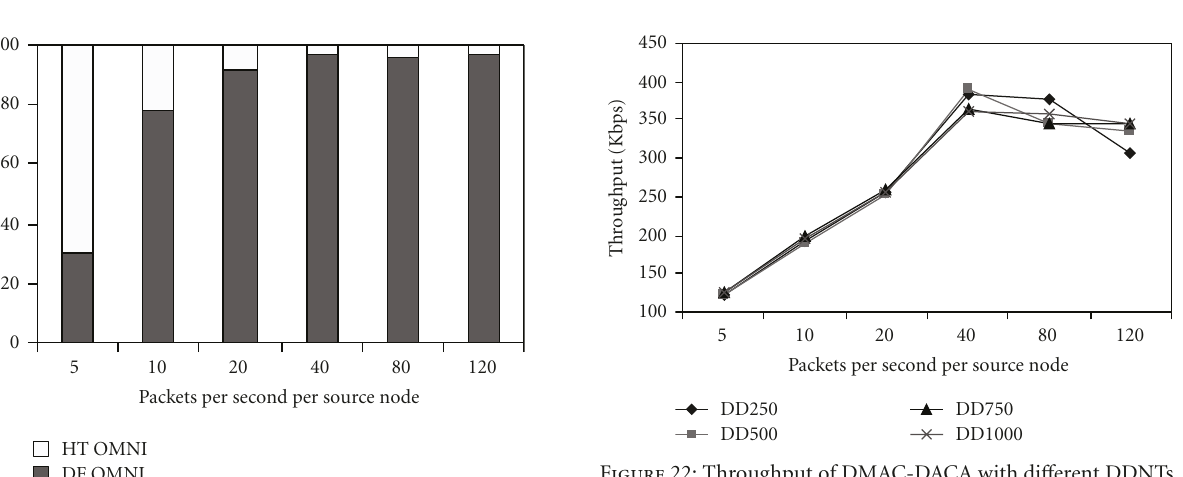
Figure 22: Throughput of DMAC-DACA with di ff erent DDNTs.